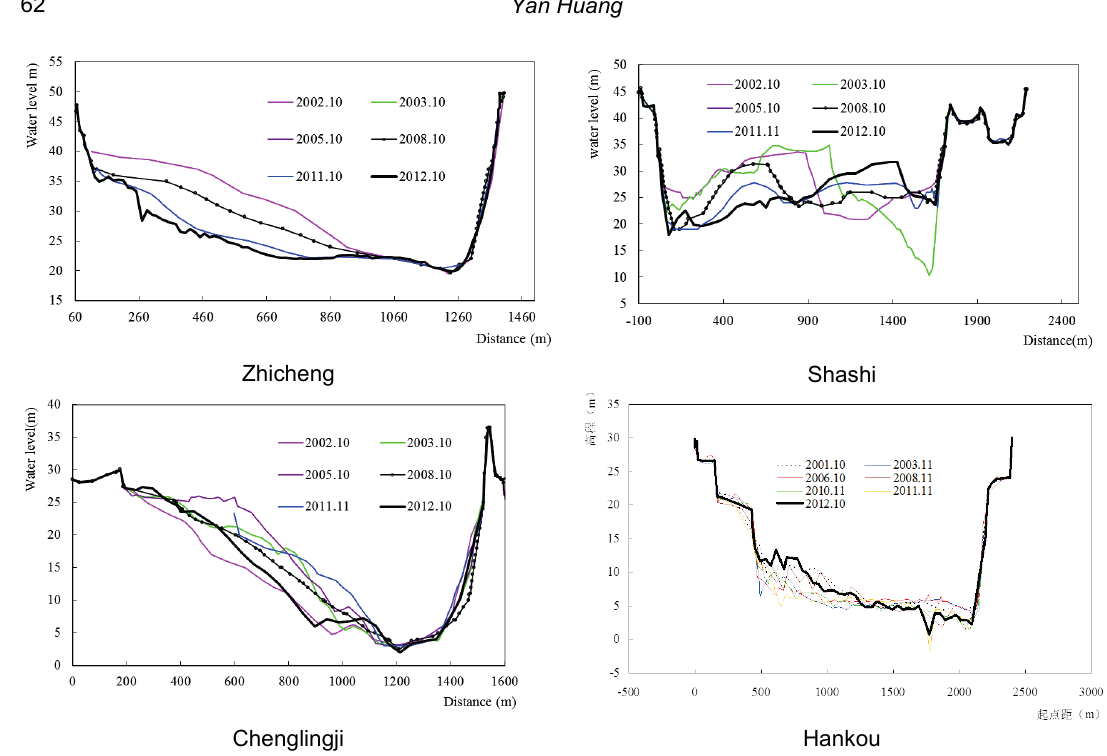
Fig. 8 Erosion at downstream areas of TGR during 2002 − 2012 shows a growing change with time and